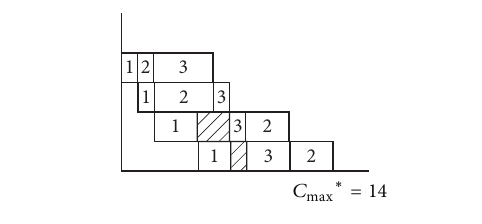
Figure 2: Optimal nonpermutation schedule.